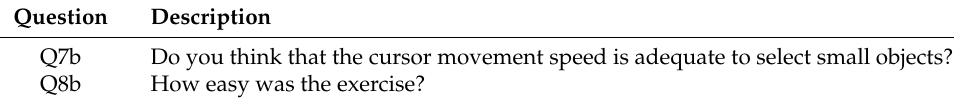
Table 4. List of modified survey questions for people with motor